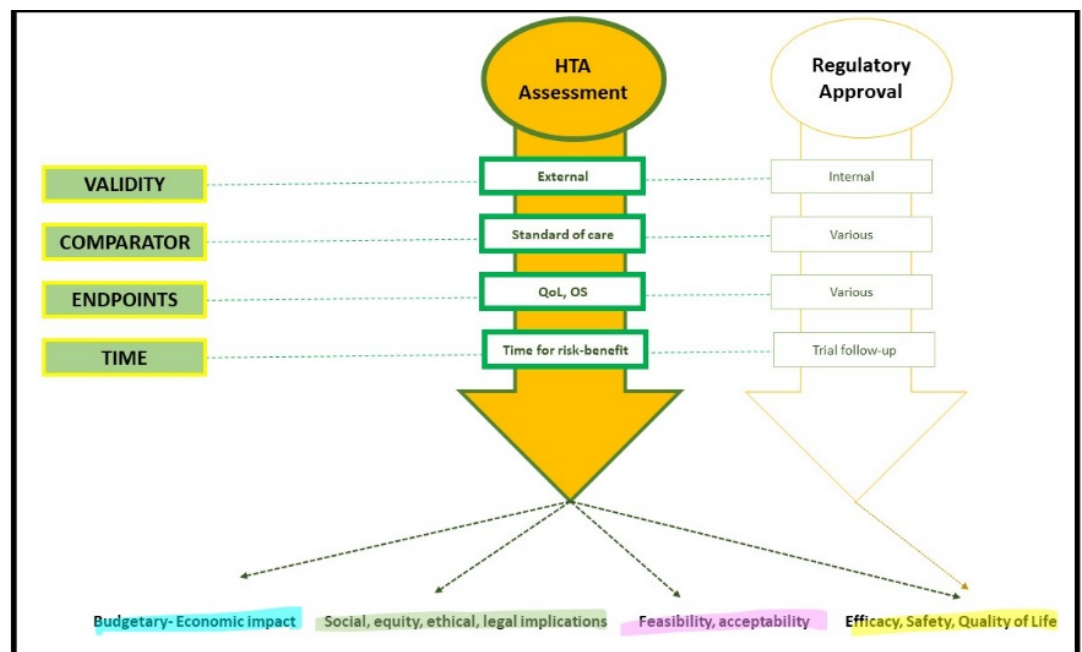
Figure 2. Structural elements and outputs of the Health Technology Assessment process versus drug approval regulation. QoL, quality of life. OS, overall survival. Note: the comparator for HTA can be a local standard of care and not mirror an international standard of care, as in the purpose of HTA. Regulatory agencies can account to some extent for the real world-evidence, with interest in the external validity of the clinical trial findings. Time for risk-benefit is intended as the interval of time deemed appropriate to consider the information on the outcome mature enough to draw conclusions; for example, in the case of overall survival in oncology clinical trials, this interval is commonly 3 to 10 years, according to the specific disease type and setting.